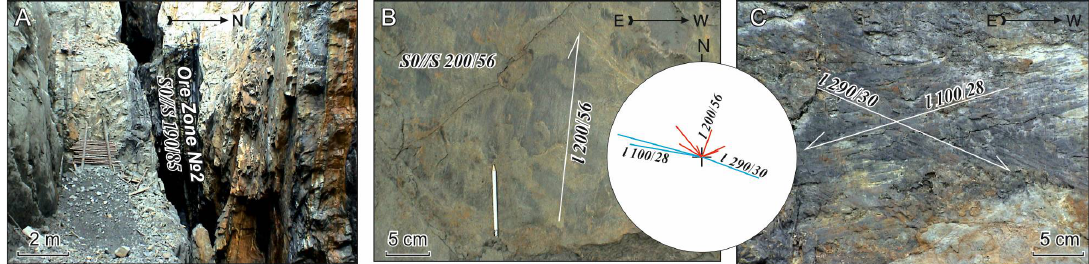
Figure 6. Ore Zone 2 ( A ), reverse-faulting ( B ) (red lines on the diagram) and strike-slip faulting ( C ) (blue lines on the diagram) slickenlines, Nagornoye deposit. Arrows show the direction of displacement of the faults’ hanging walls.